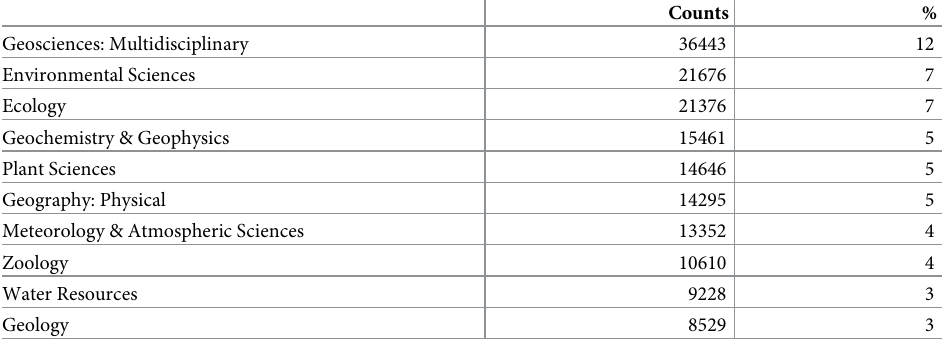
(Table 1) was “Geosciences: Multidisciplinary” (12%), followed by “Environmental sciences” and “Ecology” (7% each); several papers were assigned to more than one subject category.